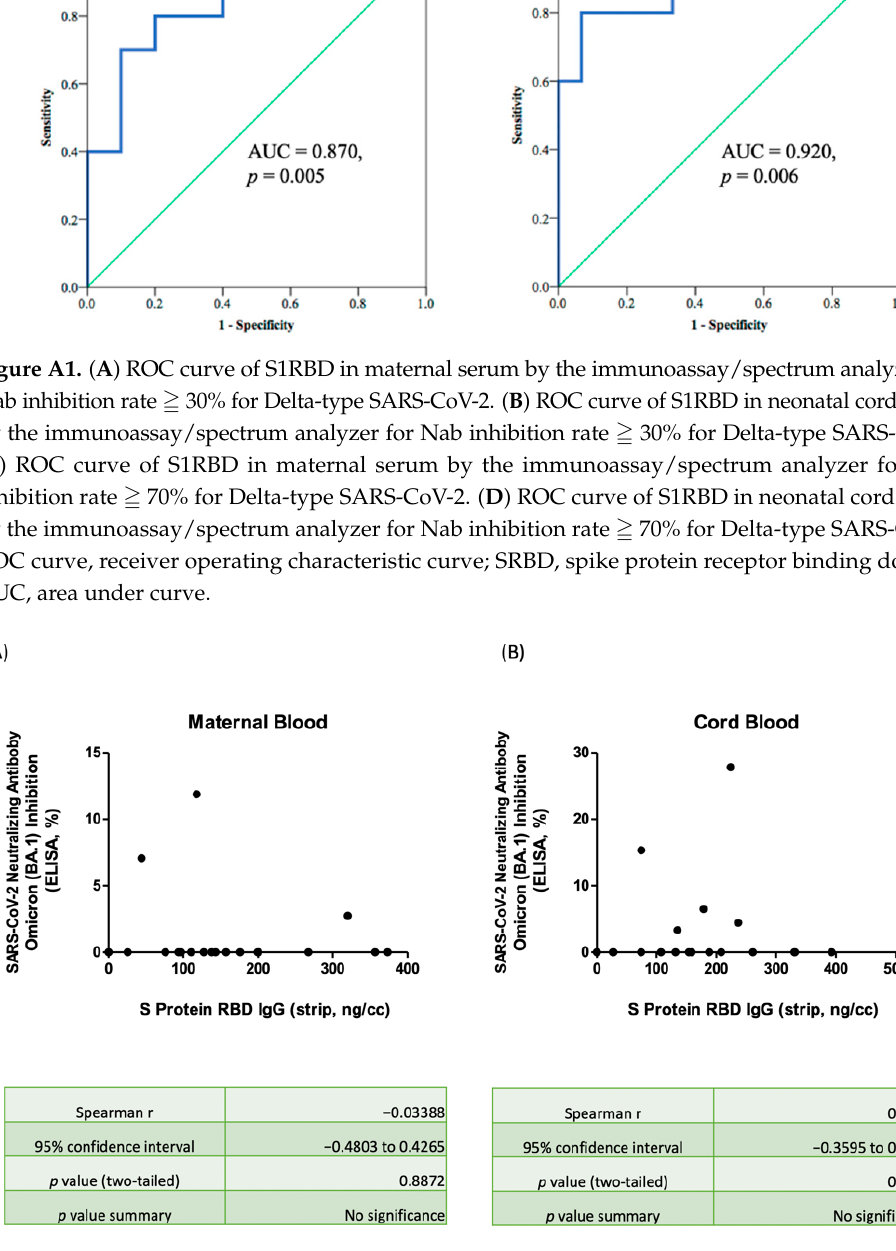
Figure A2. ( A ) Scatter plot showing the correlation between SRBD IgG by the lateral flow immunoassay/spectrum analyzer and the neutralizing antibody inhibition rates against Omicron-type SARS-CoV-2 by ELISA in maternal serum. ( B ) Scatter plot showing the correlation between SRBD IgG by the lateral flow immunoassay/spectrum analyzer and the neutralizing antibody inhibition rates against Omicron-type SARS-CoV-2 by ELISA in neonatal cord blood. SRBD, spike protein receptor binding domain; ELISA, enzyme-linked immunosorbent assay.